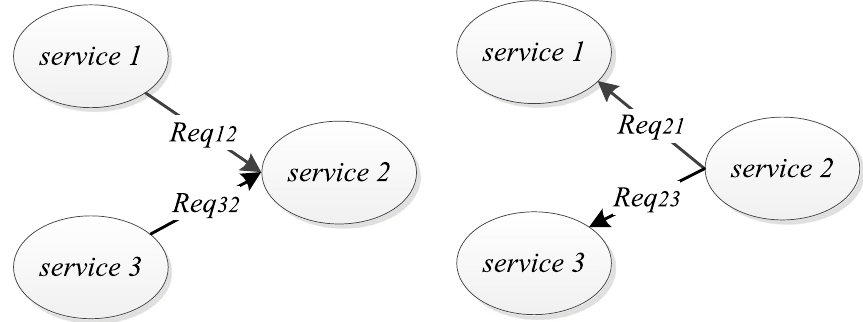
Fig. 2 Two basic cases of indirect data